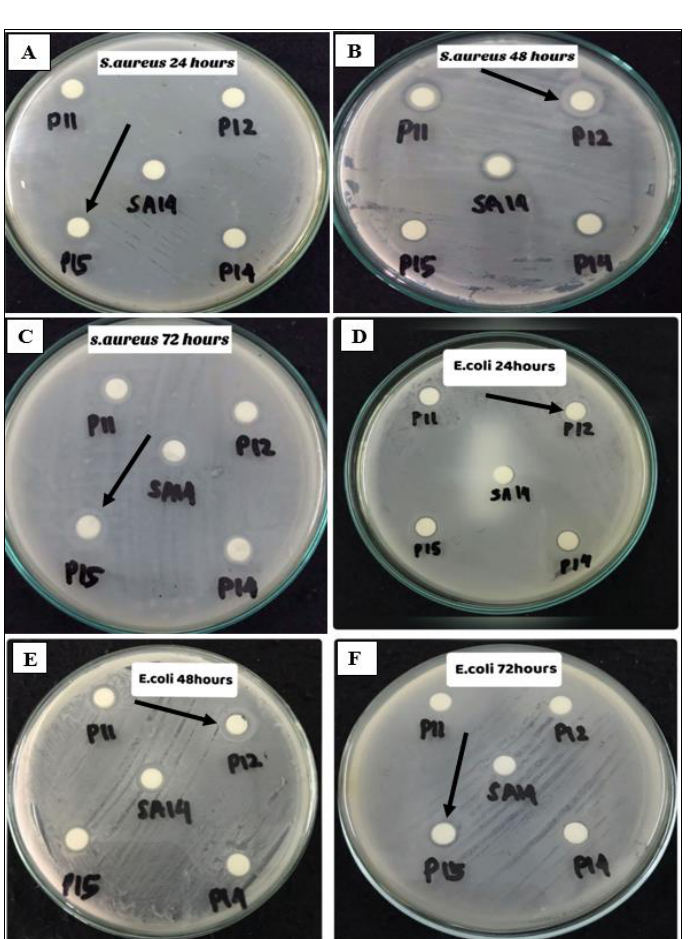
Figure 4: The results of the inhibition zone test for Bacillus subtilis UTMP11, Bacillus subtilis UTMP12, Bacillus tequilensis UTMP14, Bacillus tequilensis UTMSA14, and Bacillus subtilis UTMP15, where black arrows indicate a stronger inhibition zone at (a) 24 hours of S.aureus inhibition, (b) 48 hours of S. aureus inhibition, (c) 72 hours of S. aureus inhibition, (d) 24 hours of E. coli inhibition, and (e) 72 hours of E. coli